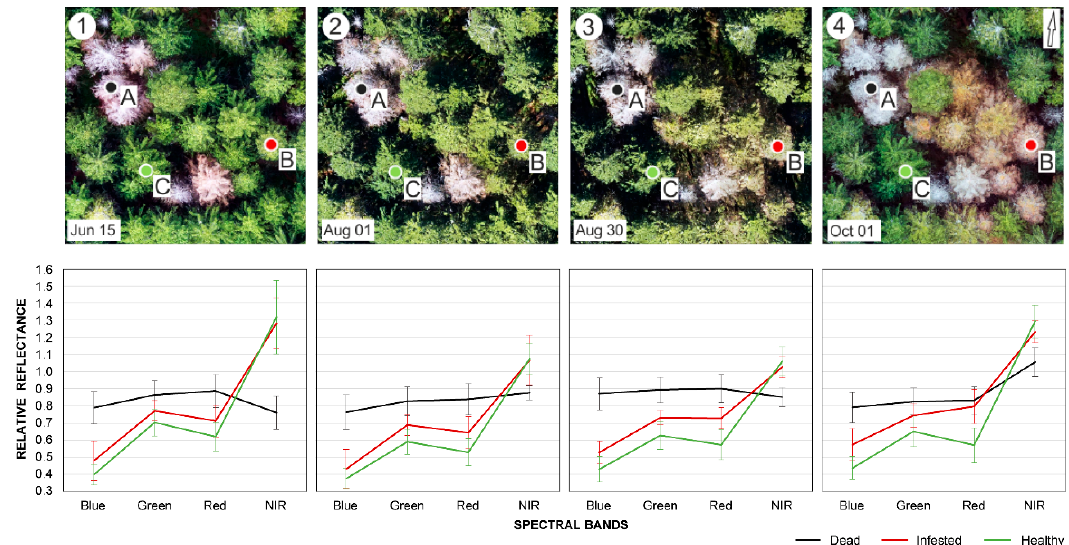
Figure 2. Spectral curves of the time series captured in different stages of the bark beetle infestation, showing dead (grey, A), infested (red, B), and healthy (green, C) trees throughout the season. The graphs represent mean relative reflectance values calculated from all infested (red), dead (black), and healthy (green) trees higher than 15 m in the study area at the individual dates. Table 1. Calculated broadband ratio indices with formulas.